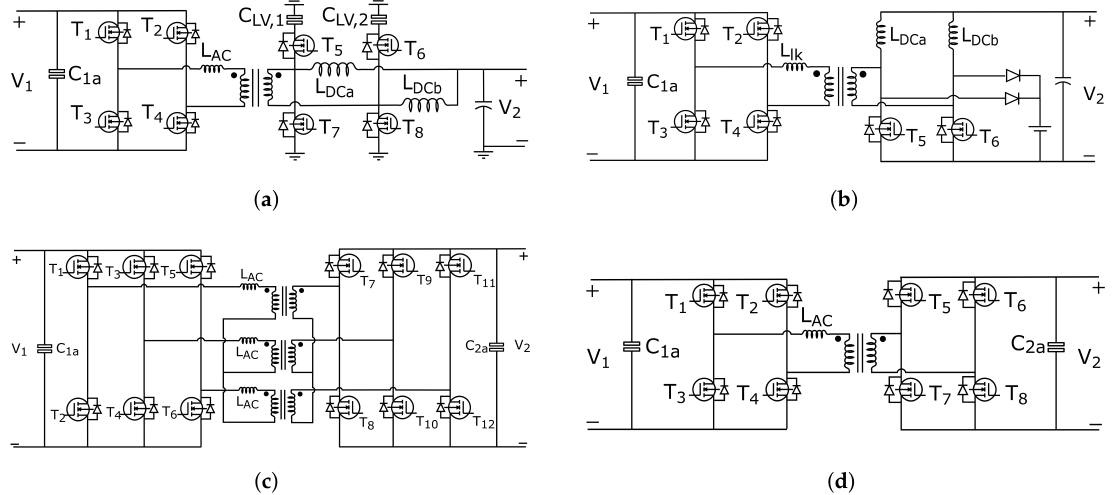
Figure 2. Schematics of the topologies considered in this study. ( a ) Active Bride Active Clamp; ( b ) Current Doubler; ( c ) Three Phase Dual Active Bridge; ( d ) Dual Active Bridge: Phase Shift and extended Triangular-Trapezoidal [12]